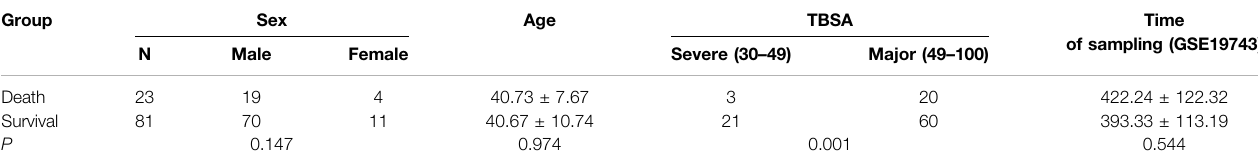
TABLE 2 | Clinical data of burn patients in GSE77791 and GSE19743.